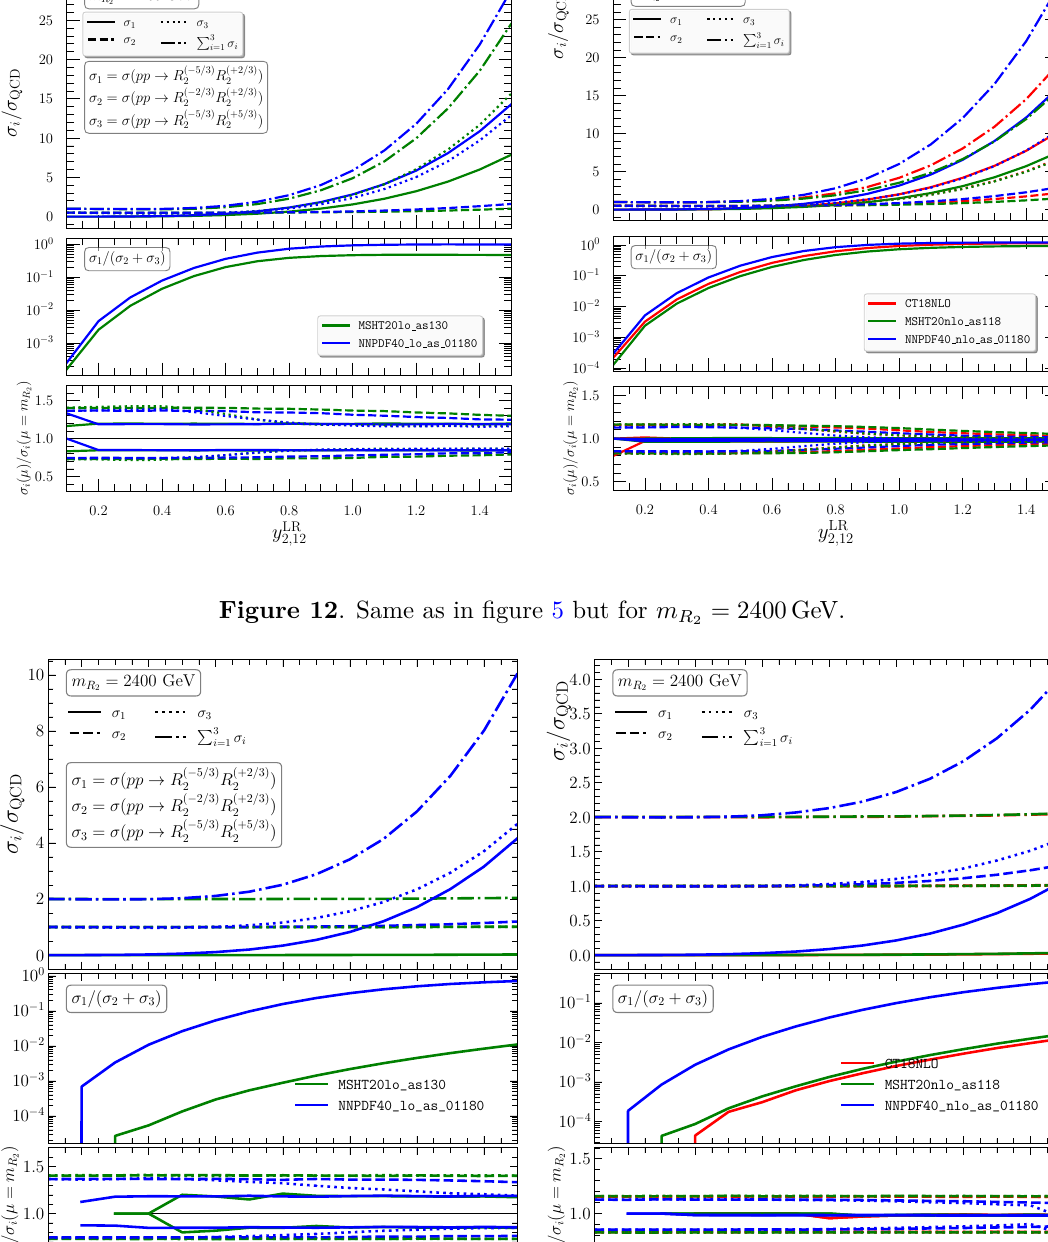
Figure 13 . Same as in figure 6 but for m R